Question: Describe this figure in one sentence.
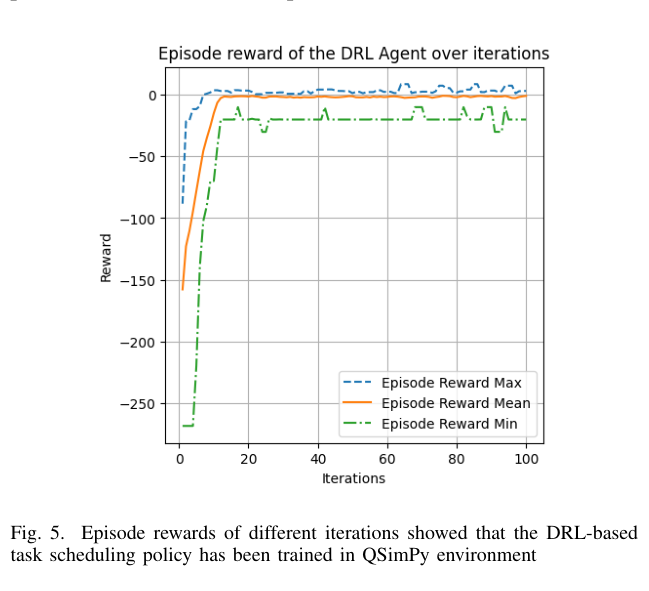
Answer: shows the episode reward values for the 105